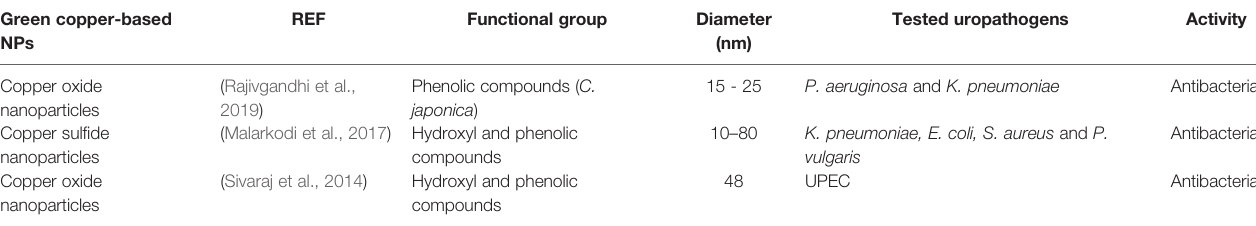
TABLE 6 | Physical characteristics of green copper-based